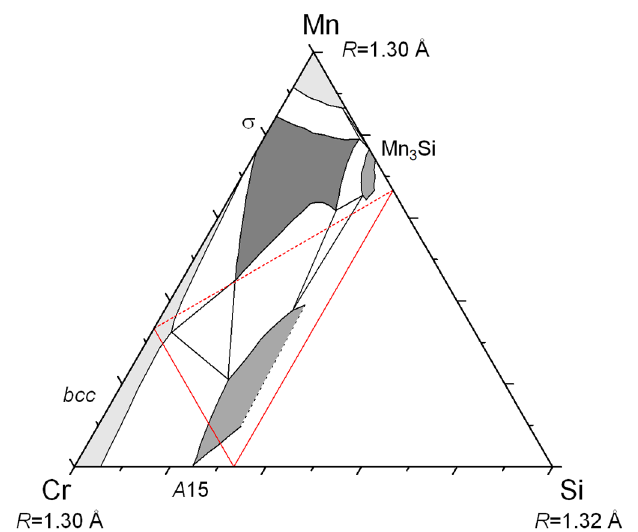
Figure 9. Isothermal section at 1000 °C of the Cr–Mn–Si system (redrawn from [21], Copyright 1960, Minerals Metals Materials Soc). The red triangle shows the three ordered stable or metastable compositions of the σ phase, Cr 2 Mn, Cr 2 Si, and Mn 2 Si, as in Figure 2 (solid lines: normal substitution, dashed line: site